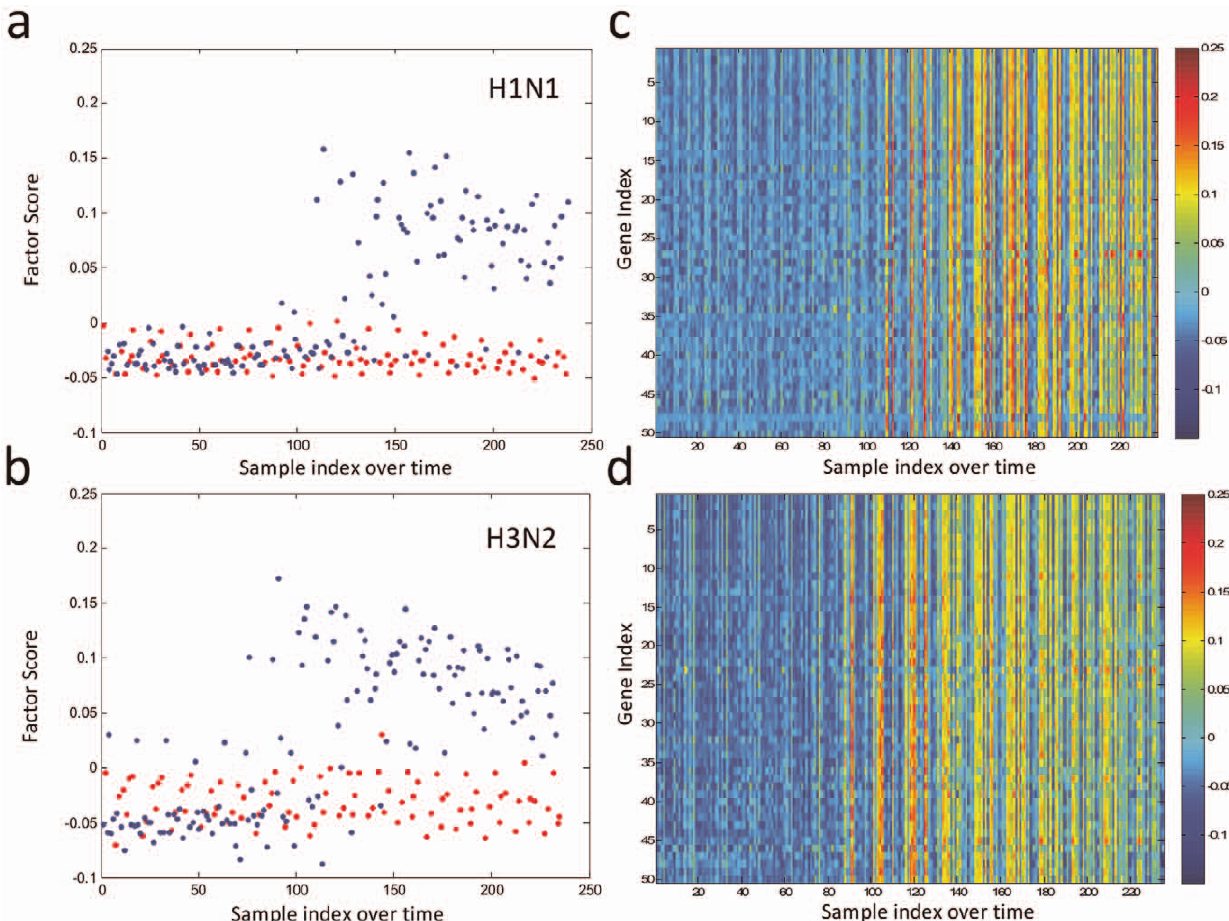
Figure 2. Gene expression signatures expressed through factor scores. An influenza gene expression signature, or factor, evolves over time in symptomatic individuals (blue dots) and distinguishes between symptomatic and asymptomatic individuals (red dots) for both H1N1 (A) and H3N2 (B) viruses at later time points. Heat maps of the top 50 genes in the discriminative factor for H1N1 (c) and H3N2 (d) as they develop over time are shown.